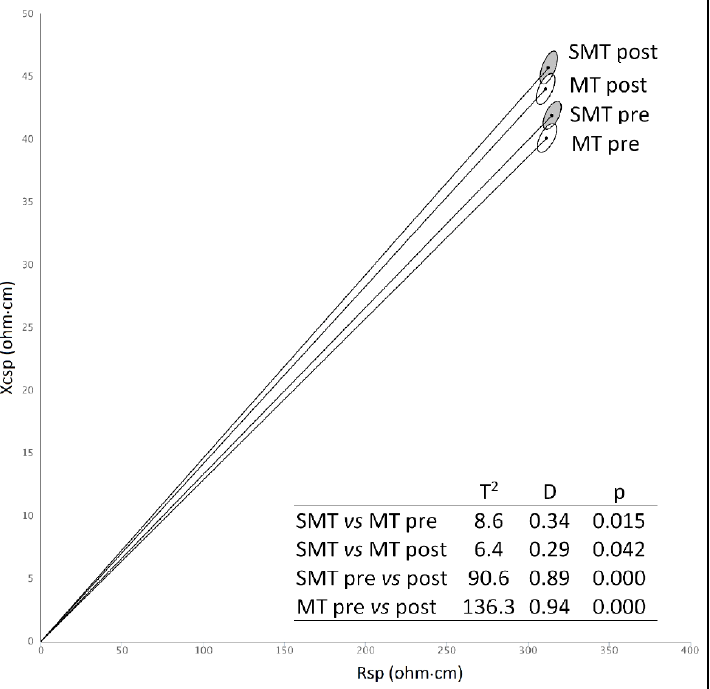
Figure 2. Confidence ellipses with T 2 Hotelling’s test in the two groups before and after training. Legend: SMT: Sports and Military Training; MT: Military Training only. Comparisons between SMT and MT were performed using two-sample Hotelling’s T2 tests, while those between pre- and post- training groups were performed with paired one-sample Hotelling’s T 2